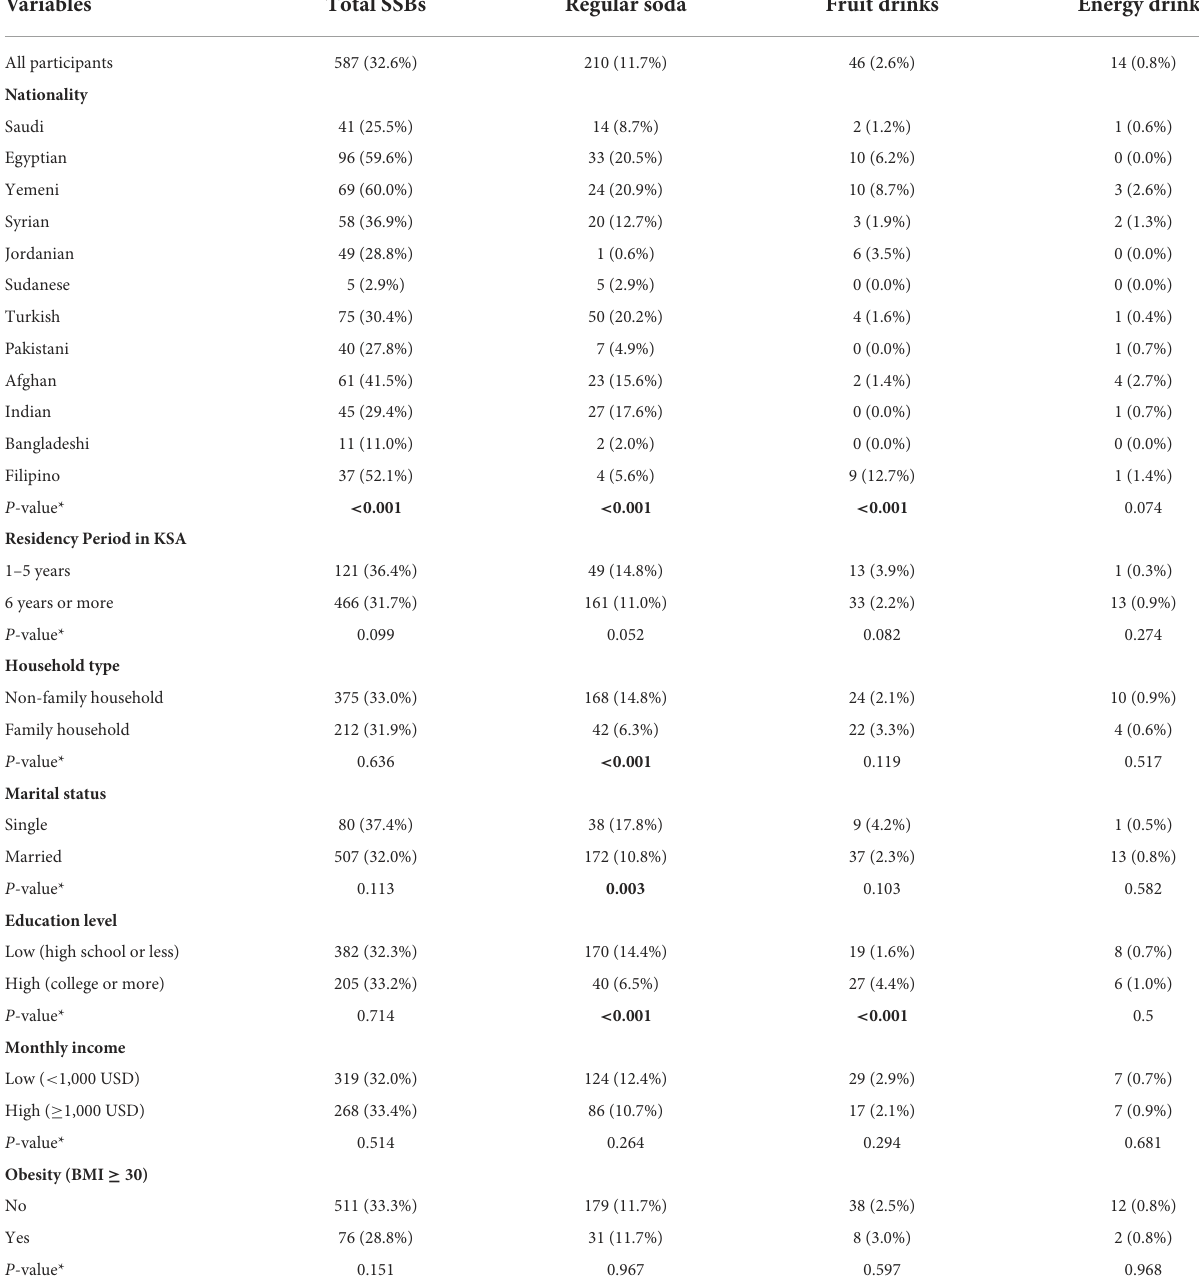
TABLE 2 Prevalence of daily sugar-sweetened beverages (SSBs) consumption among study participants ( n = 1,800) stratified by sociodemographic variables and obesity.